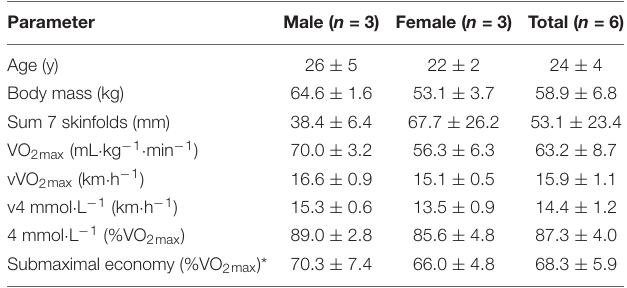
TABLE 2 | Baseline physiological data for athletes during the team holding camp ( n = 6). Parameter